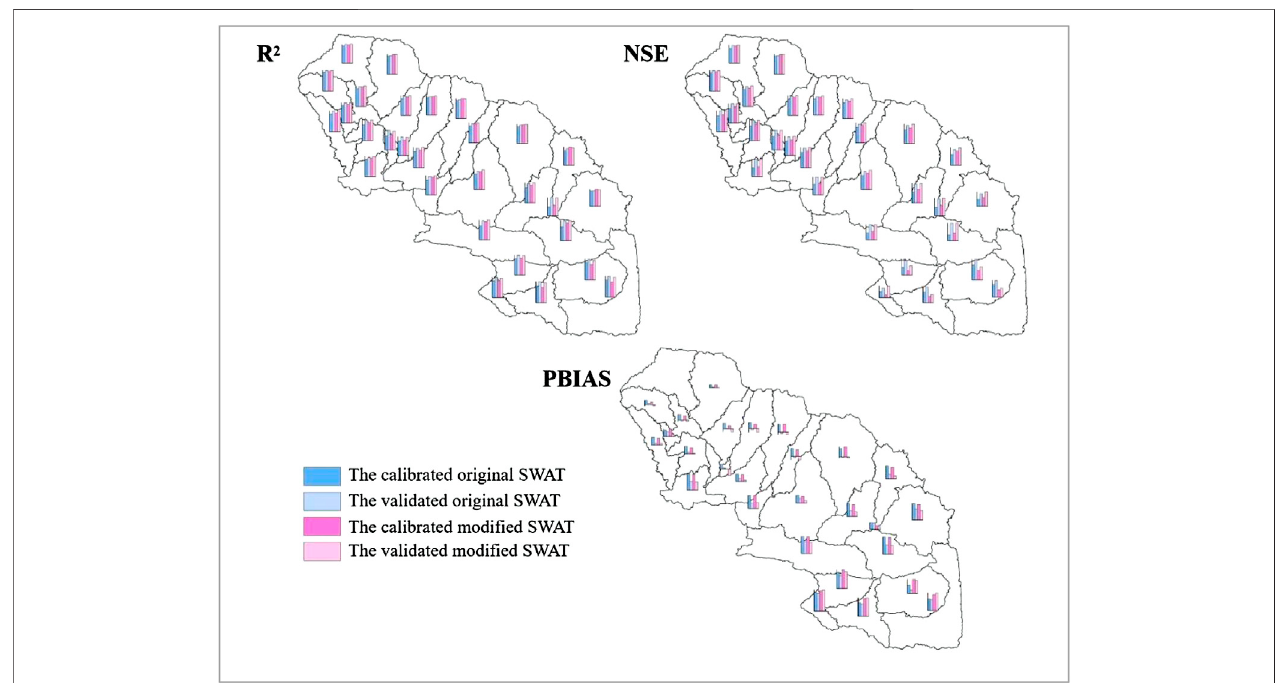
FIGURE10| Theperformanceoftheoriginalandmodi fi edSoilandWaterAssessmentTool(SWAT)modelsinsimulatingthemonthlyevapotranspirationatthelevel of subbasins.